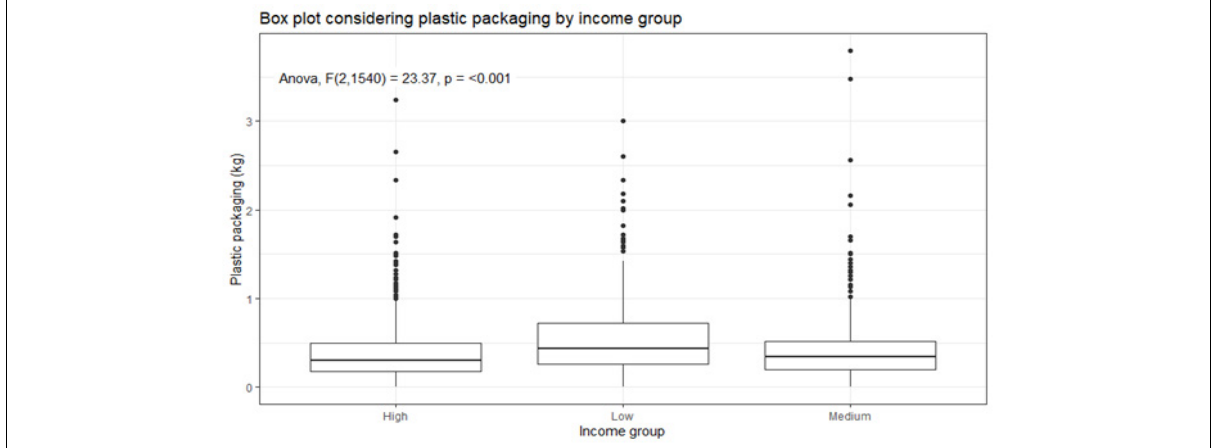
Figure 5: Box plot depicting differences in means of the plastic packaging waste fraction between different income groups in